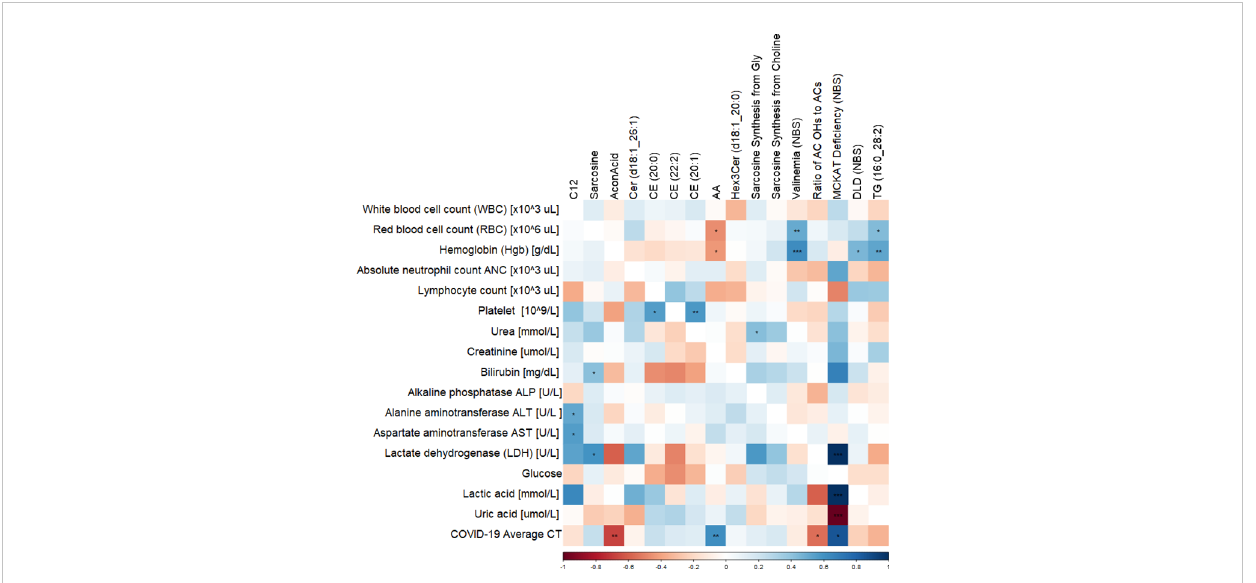
FIGURE 5 Correlation matrix showing the Spearman ’ s association between the signi fi cant metabolites and clinical traits in BCG-positive diabetic individuals. ***/**/* signi fi es <0.001/<0.01/<0.05 p